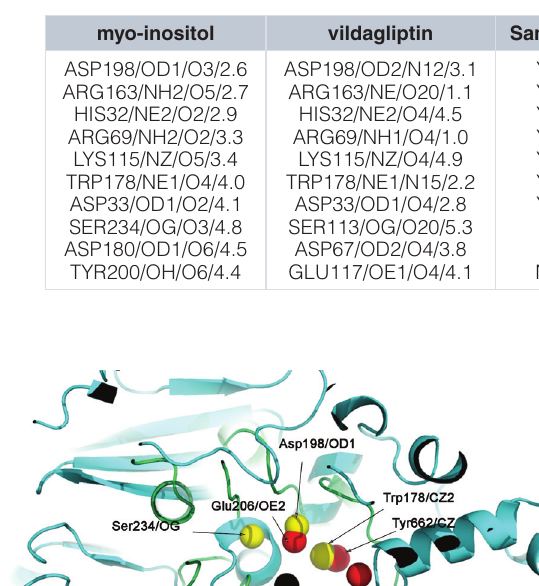
Table 5. Atoms of myo-inositol and vildagliptin that make contact to the residues of the PI-PLC structure (PDBid:1PTGA). These interactions exclude hydrophobic interactions, and the first closest ten atoms are chosen. Out of ten, seven residues obtained by docking vildagliptin using DOCLASP are seen to be equivalent to those that are known to bind myo-inositol to the PI-PLC structure 13 , while two more have the same amino acid type (marked by asterisks). Only one pair has a different amino acid type (Tyr200 for myo-inositol and Glu117 for vildagliptin). Further validation is